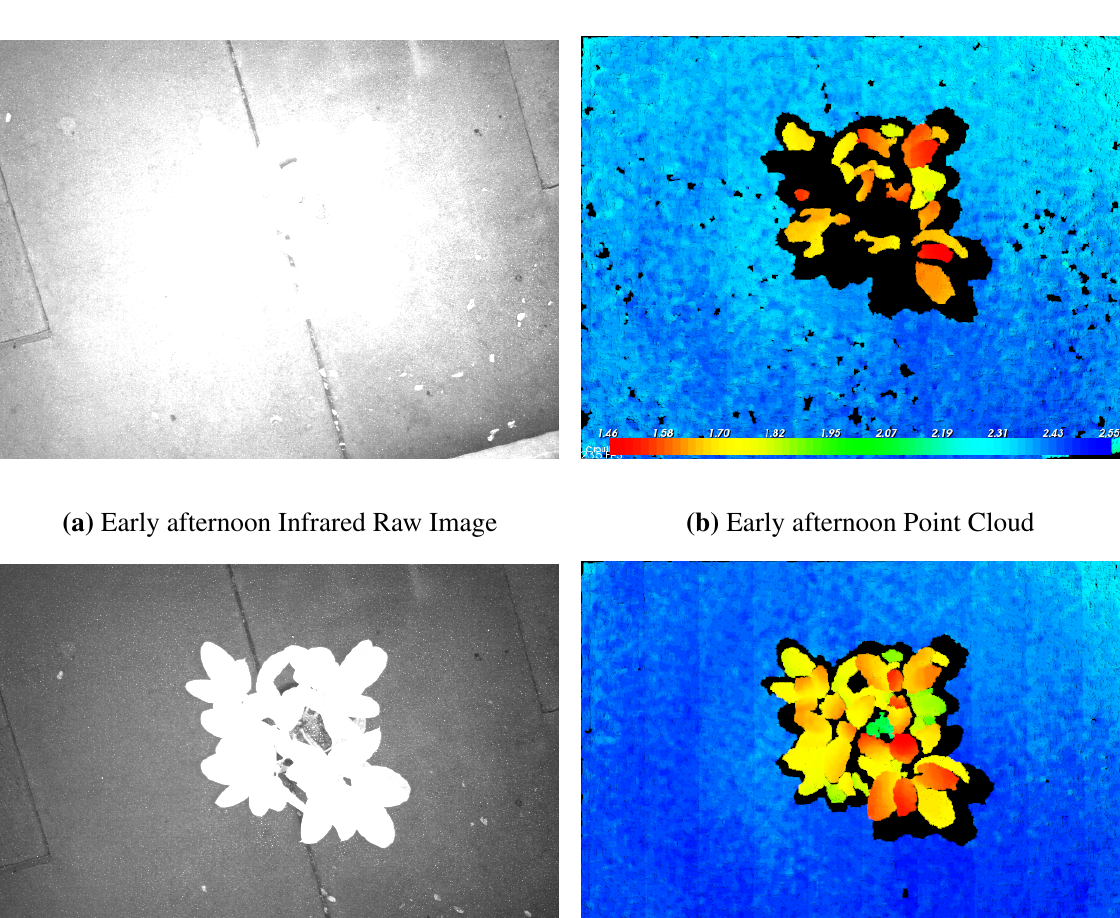
Figure 3. Comparison between raw infrared output from Kinect ( a , c , e ) and corresponding point clouds ( b , d , f ) in different light conditions. All images are for a potted rubber tree plant that was about 1.10 m tall ( i.e ., Figure 1(a)). Point cloud color scale is distance (meters) from the sensor at